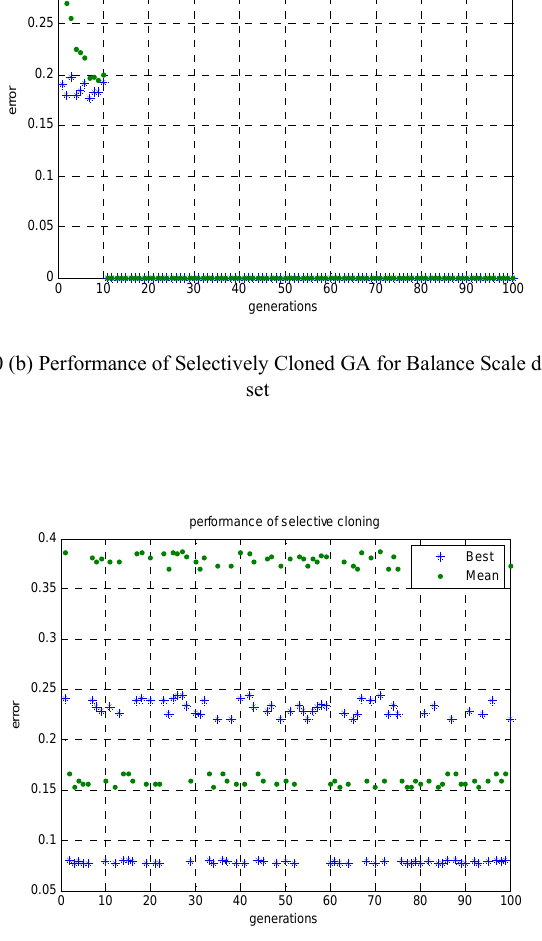
Fig 11(a) Performance of GA for Balloon data set Fig 11 (b) Performance of Selectively Cloned GA for Balloon data